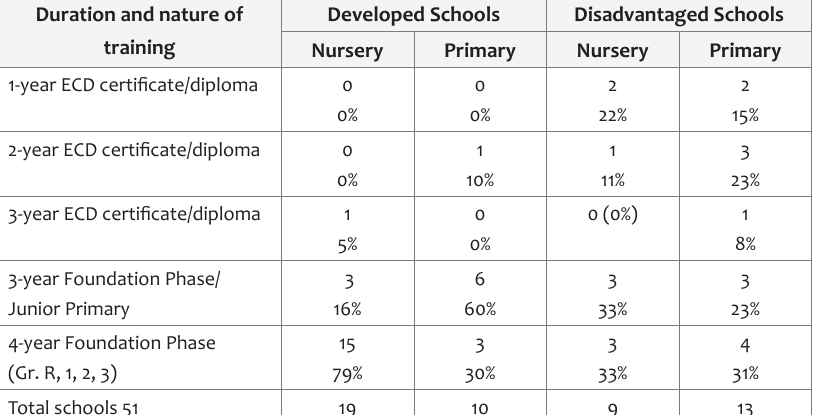
Table 2: Nature of teacher training Duration and nature of Developed Schools Disadvantaged Schools training Nursery Primary Nursery